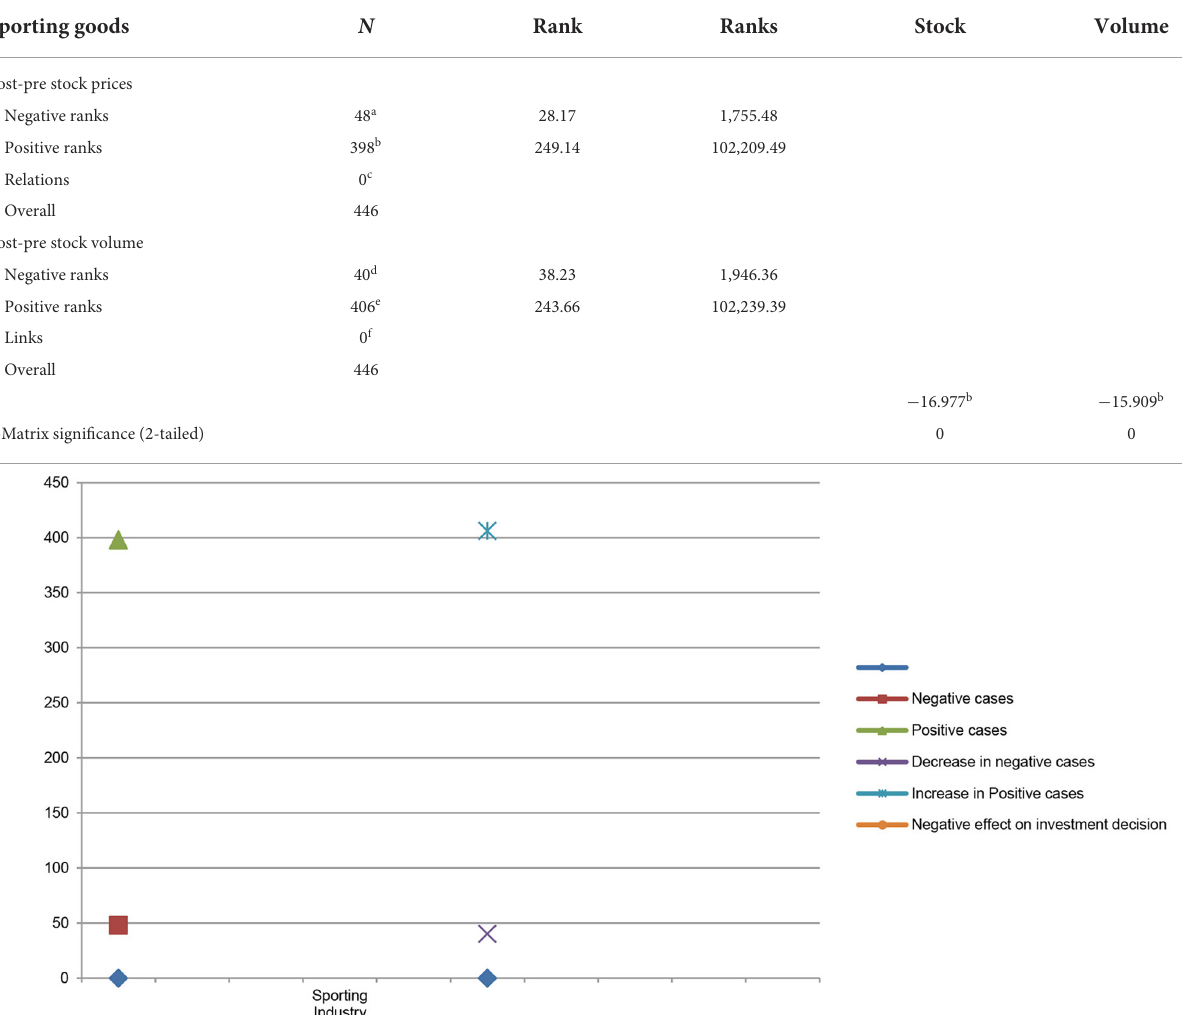
TABLE 3 Multiple regression of the sporting